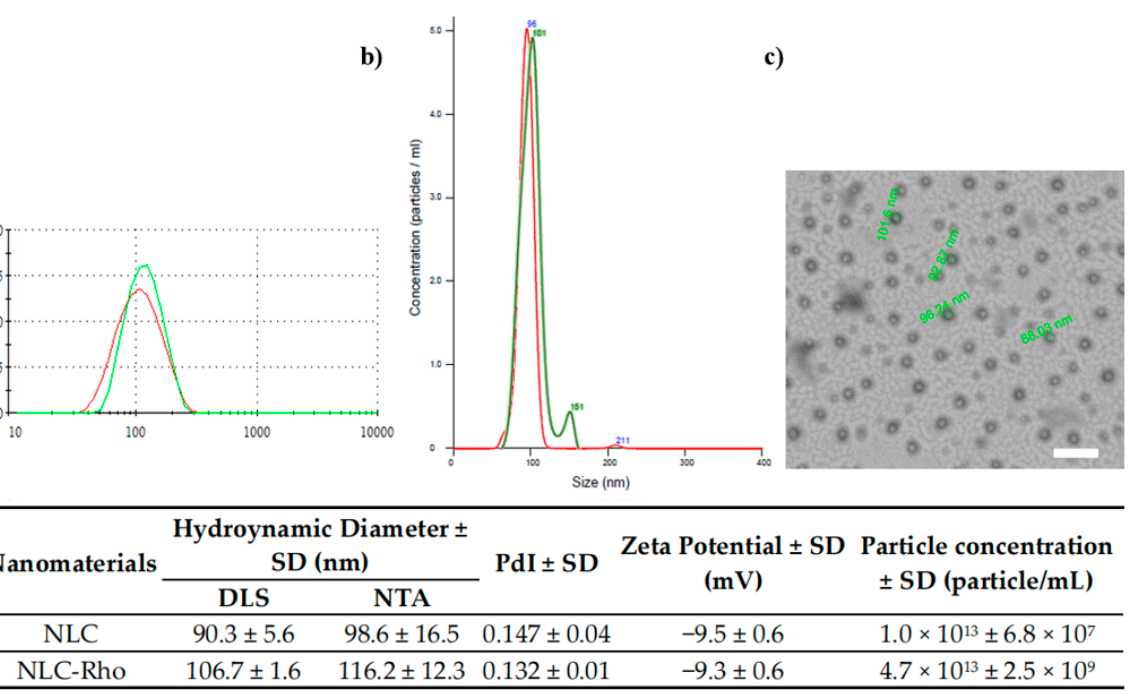
Figure 1. Characterization of NLC (red line) and NLC-Rho (green line). ( a ) Hydrodynamic diameter distribution, ( b ) Nanoparticle Tracking Analysis, ( c ) TEM image of NLC (the bar represents 500 nm), and ( d ) Hydrodynamic diameter (nm), PdI, and zeta potential (mV) by